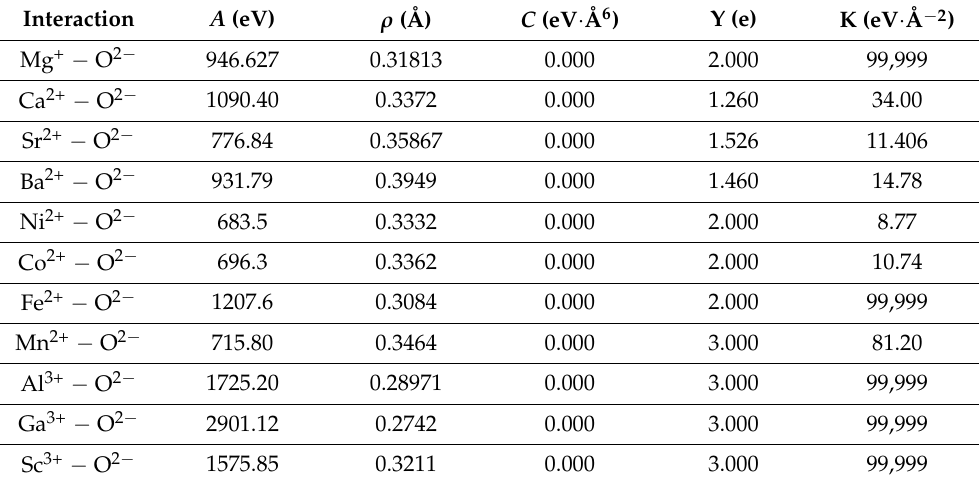
Table 5. Interatomic potential parameters used for dopants in the atomistic simulations